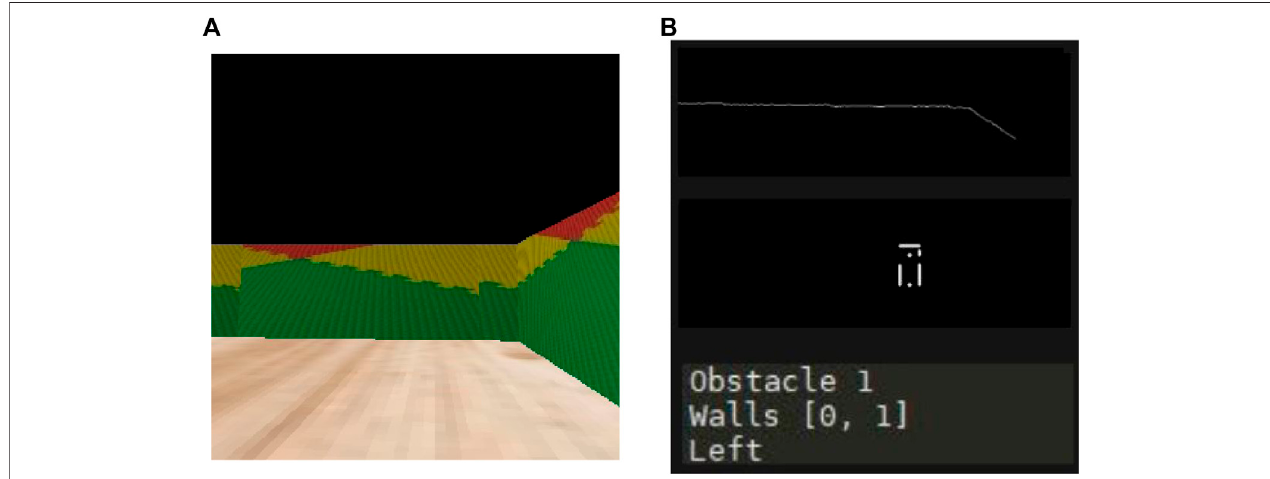
FIGURE 7 | Mapping and path planning integration. Second demo. (A) What the robot sees. (B) Algorithms output.